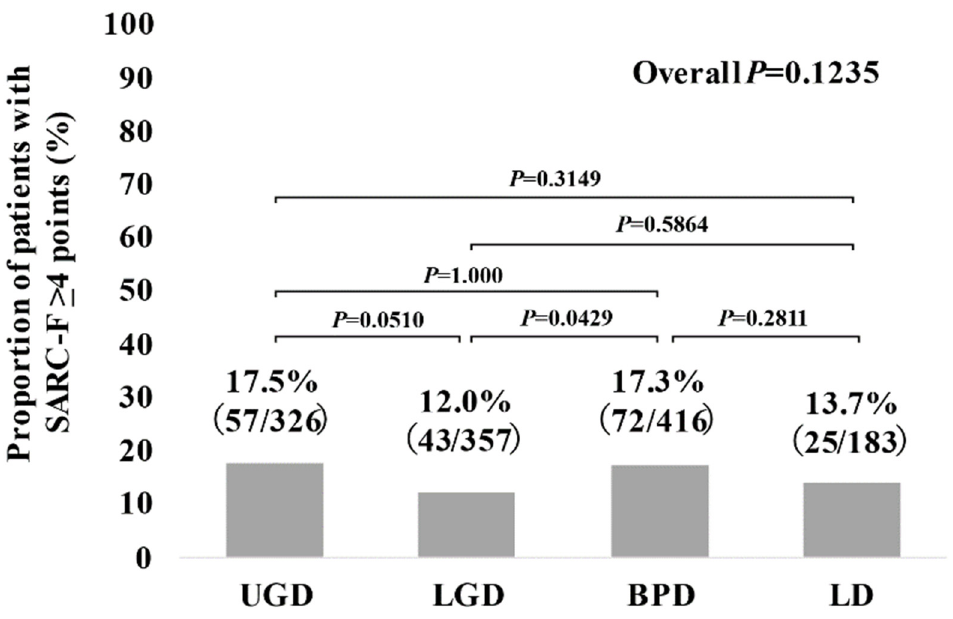
Figure 3. The proportion of patients with SARC-F ≥ 4 points according to the diseases (UGD, LGD, BPD, and LD). BPD, and